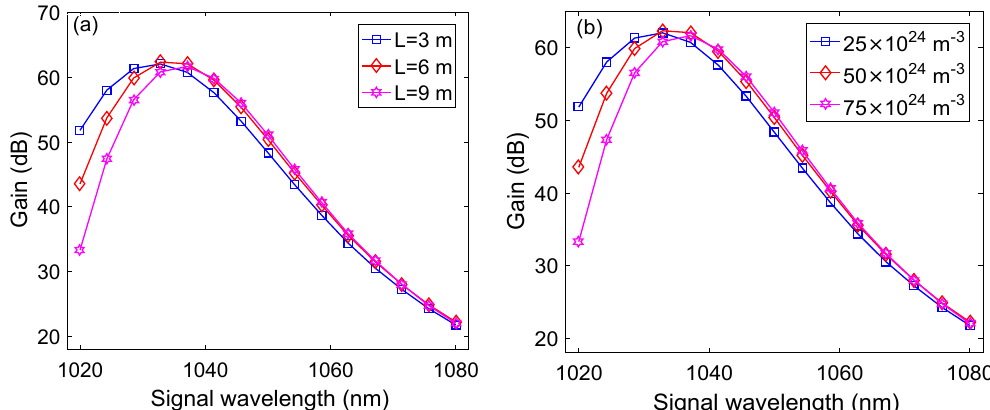
Figure 5. Signal wavelength versus gain plots at: ( a ) different lengths of Y-2; ( b ) different doping concentrations of Yb 3 + .